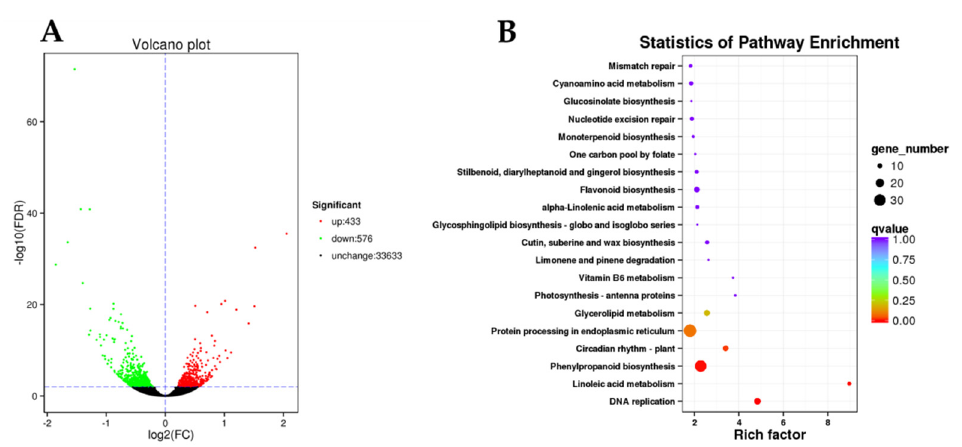
Figure 4. Volcano plot of differentially expressed transcripts ( A ) and KEGG enrichment analysis of DEGs ( B ) in ‘Yinghong 9’ and ‘Huangyu’.